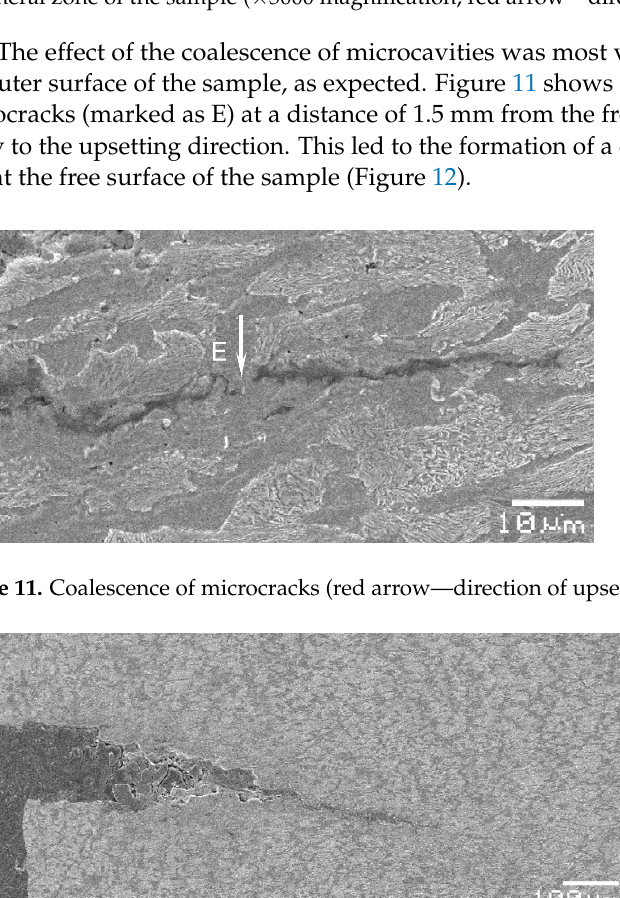
Figure 12. Macroscopic crack at free surface (red arrow—direction of upsetting).